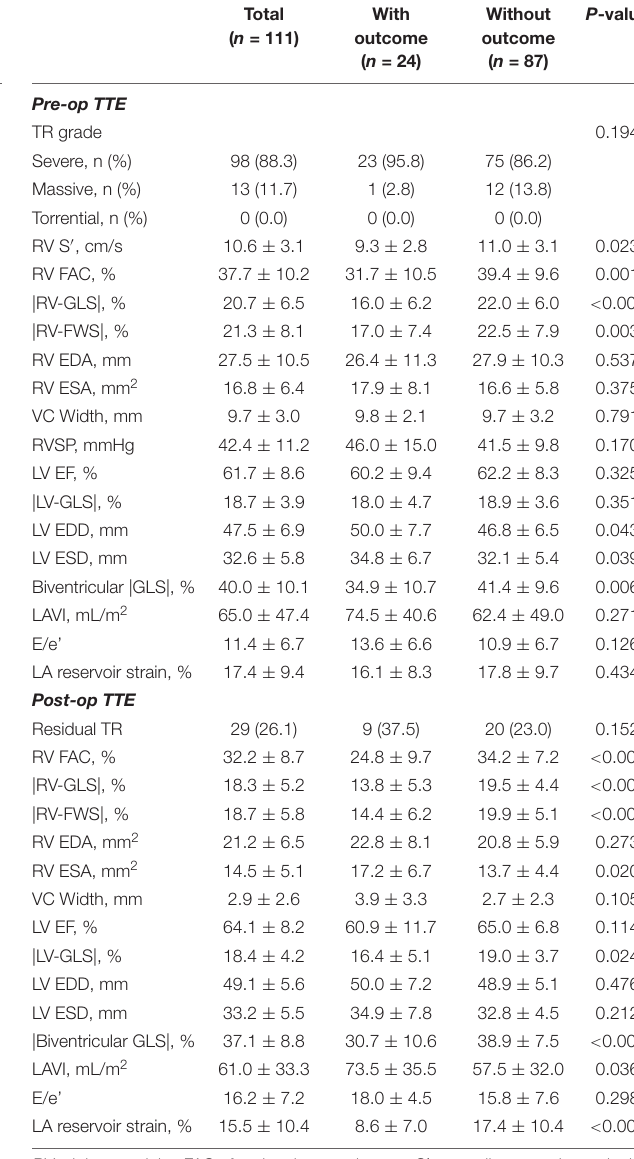
RV, right ventricle; FAC, fractional area change; S (cid:48) , systolic excursion velocity; |GLS|, absolute value of global longitudinal strain; |FWS|, absolute value of free wall strain; EDA, end diastolic area; ESA, end systolic area; VC, vena contracta; HV, hepatic vein; EF, ejection fraction; EDD, end diastolic dimension; ESD, end systolic dimension; LAVI, left atrial volume index; E/e (cid:48) , ratio of early diastolic mitral inflow velocity to early diastolic mitral annular tissue velocity.